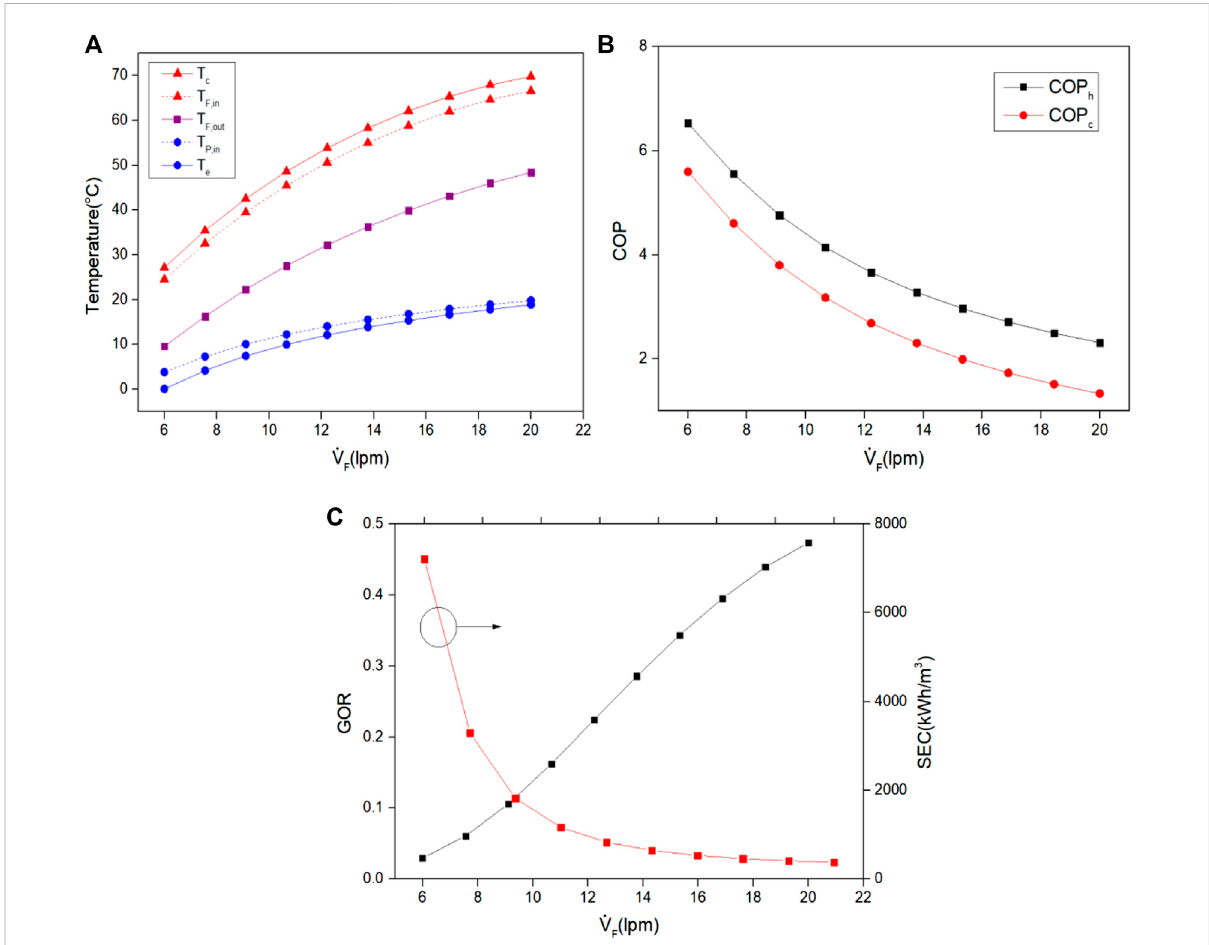
FIGURE 5 Effectsofmass fl owrateoffeedwaterstreamon (A) temperaturesoftheevaporator,condenser,feedwater,andpermeate, (B) COP h andCOP c , and (C) GOR and